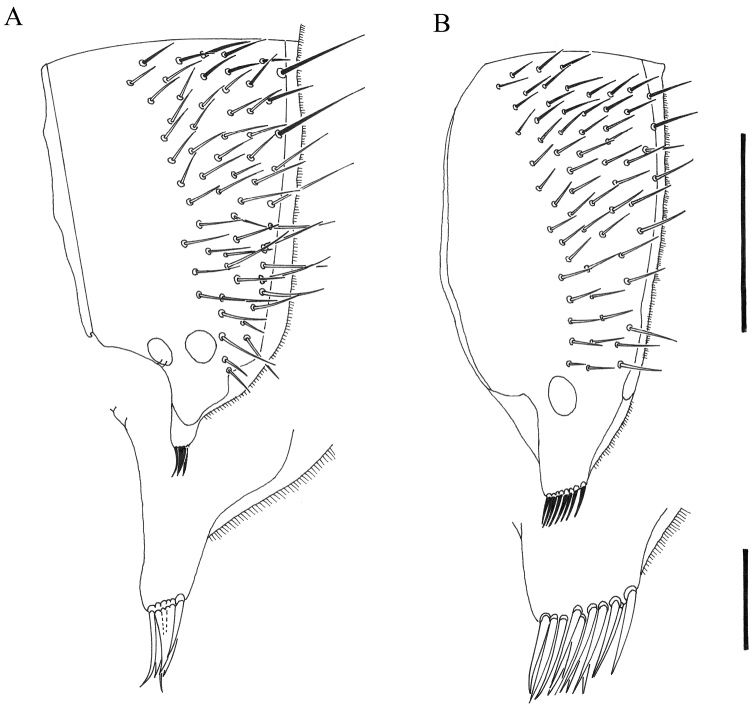
Posteroventral process on 5th tergite, male: AO.sabulosumBOrthoceratiumlacustre. Scale bars: 0.5 mm (tergites) and 0.1 mm (processes).